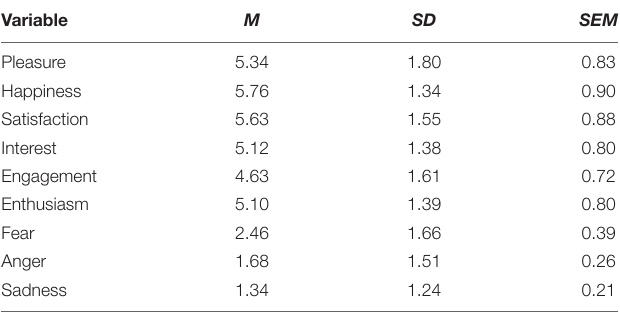
TABLE 1 | Descriptive statistics with mean (M) standard deviation (SD) and standard error of mean (SEM) for self-reported episode